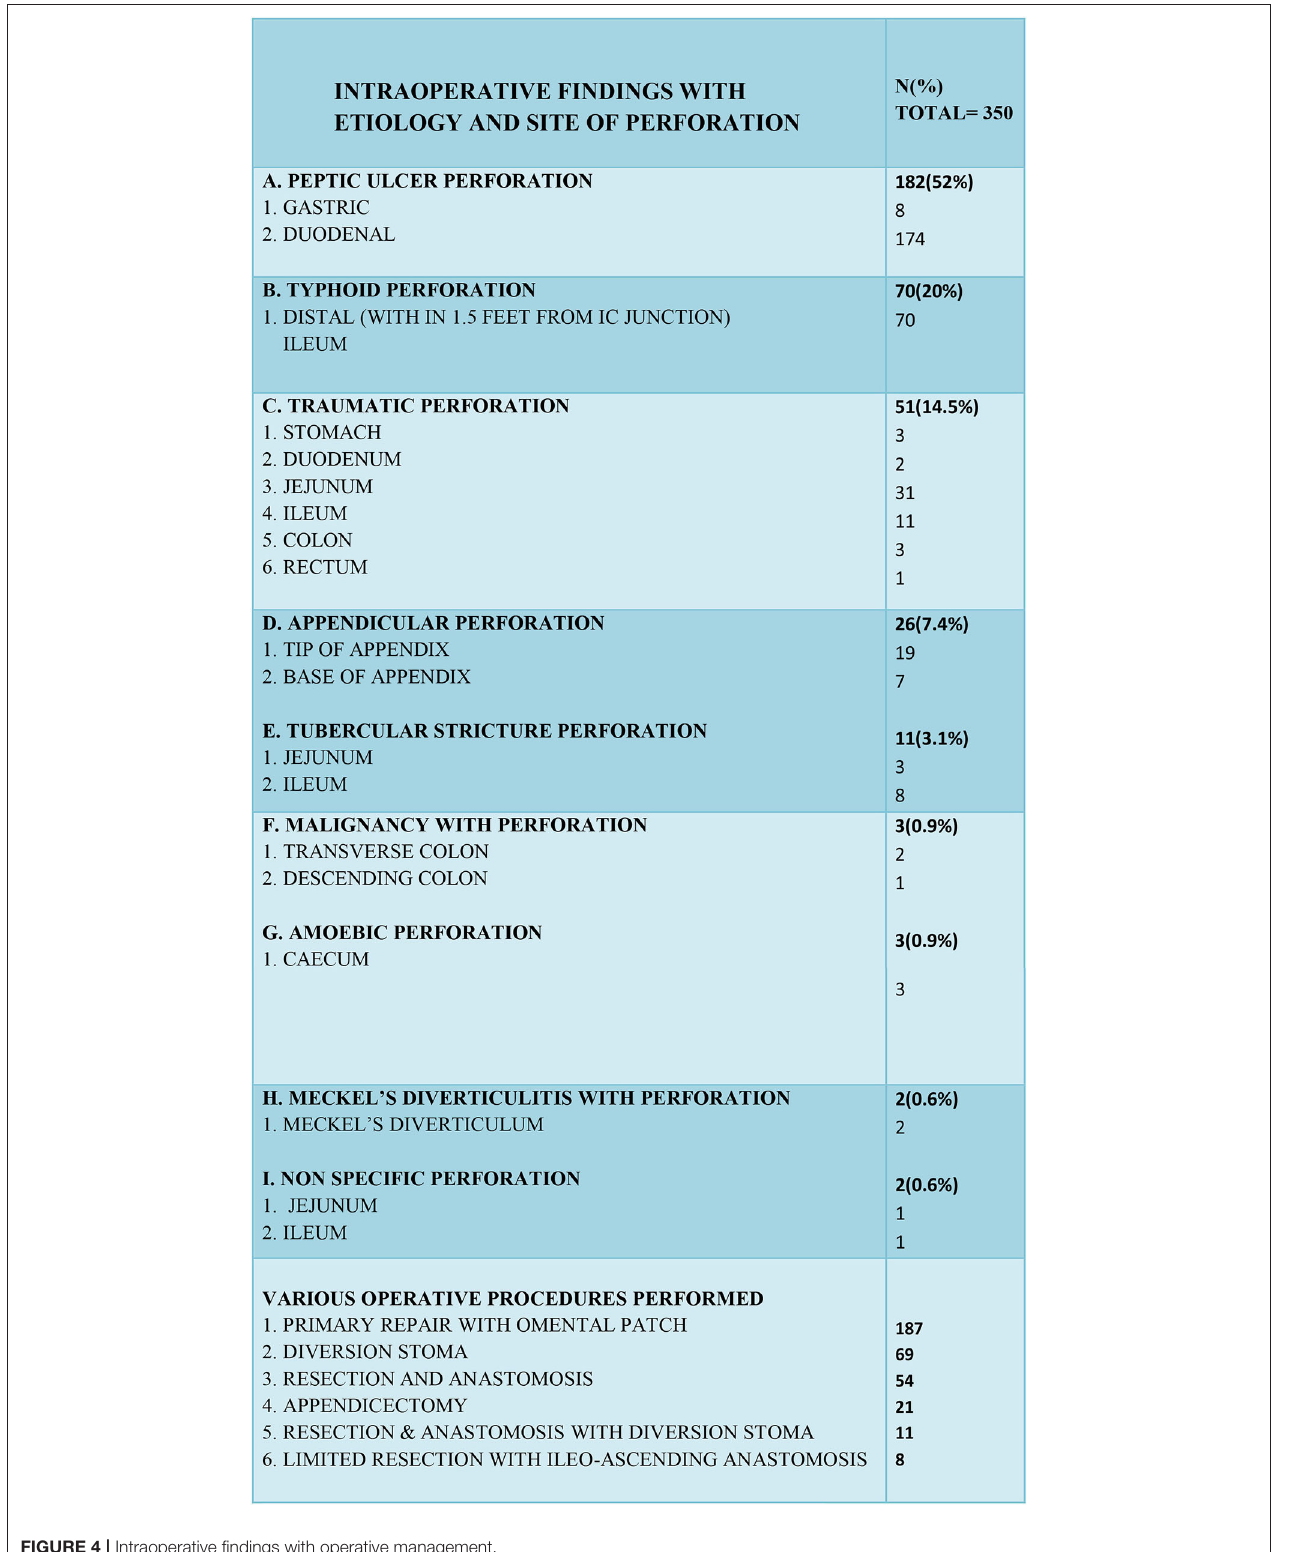
FIGURE 4 | Intraoperative findings with operative management.